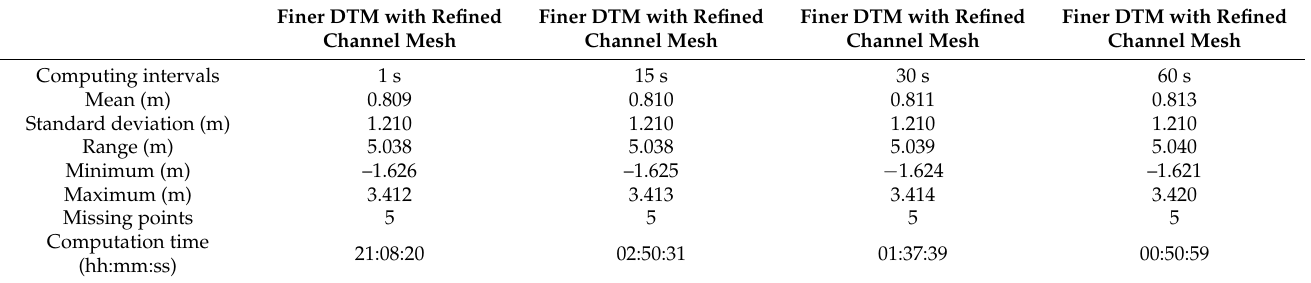
Table 3. Descriptive statistics of the residuals between the 82 validation points and their corresponding points in the HEC-RAS simulation with the finer DTM (0.50 m) with refined channel mesh. Finer DTM with Refined Channel Mesh